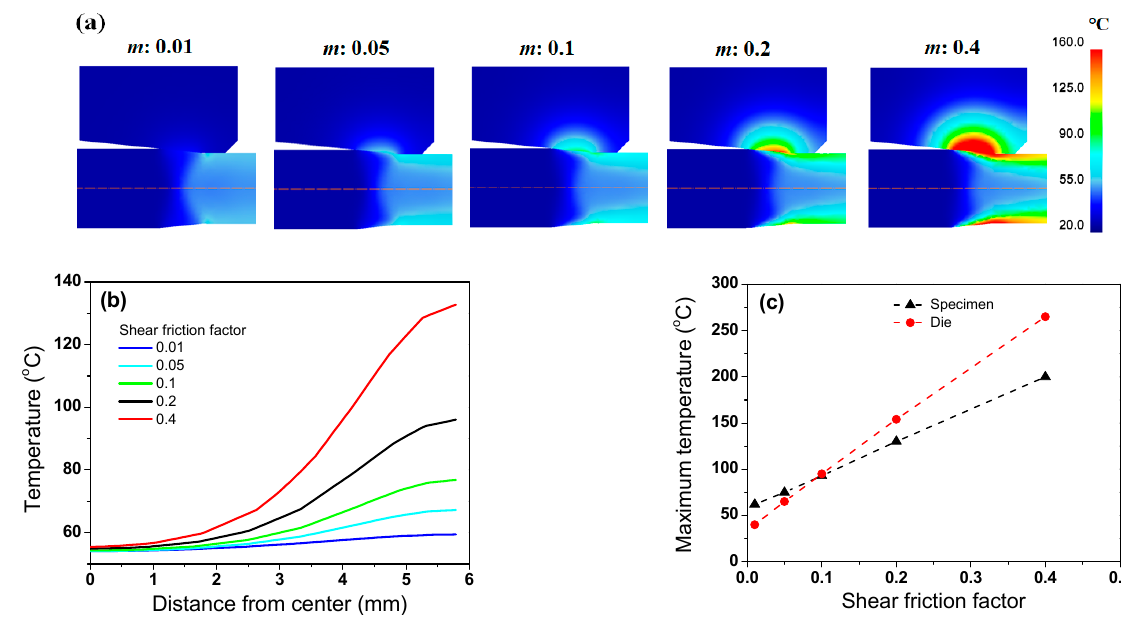
Figure 7. Comparison of temperature ( a ) contours and ( b ) profiles along radial direction of wire at die exit; ( c ) T max of wire and die vs. shear fraction